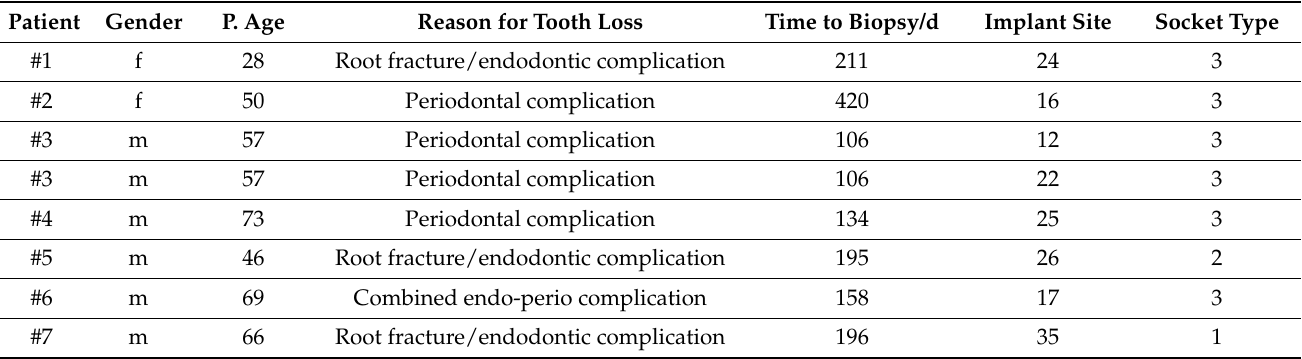
Table 1. Descriptive data about the “socket preservation”